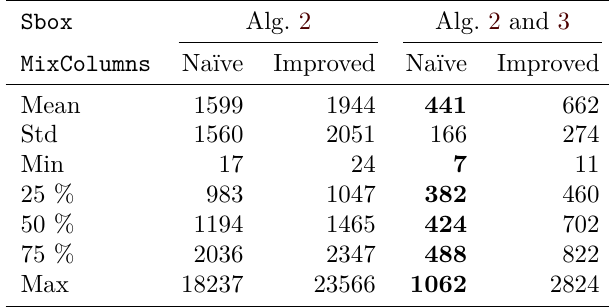
Table 14: Computation time (sec) for 5 rounds of AES on a sample of 259 sparse input/output